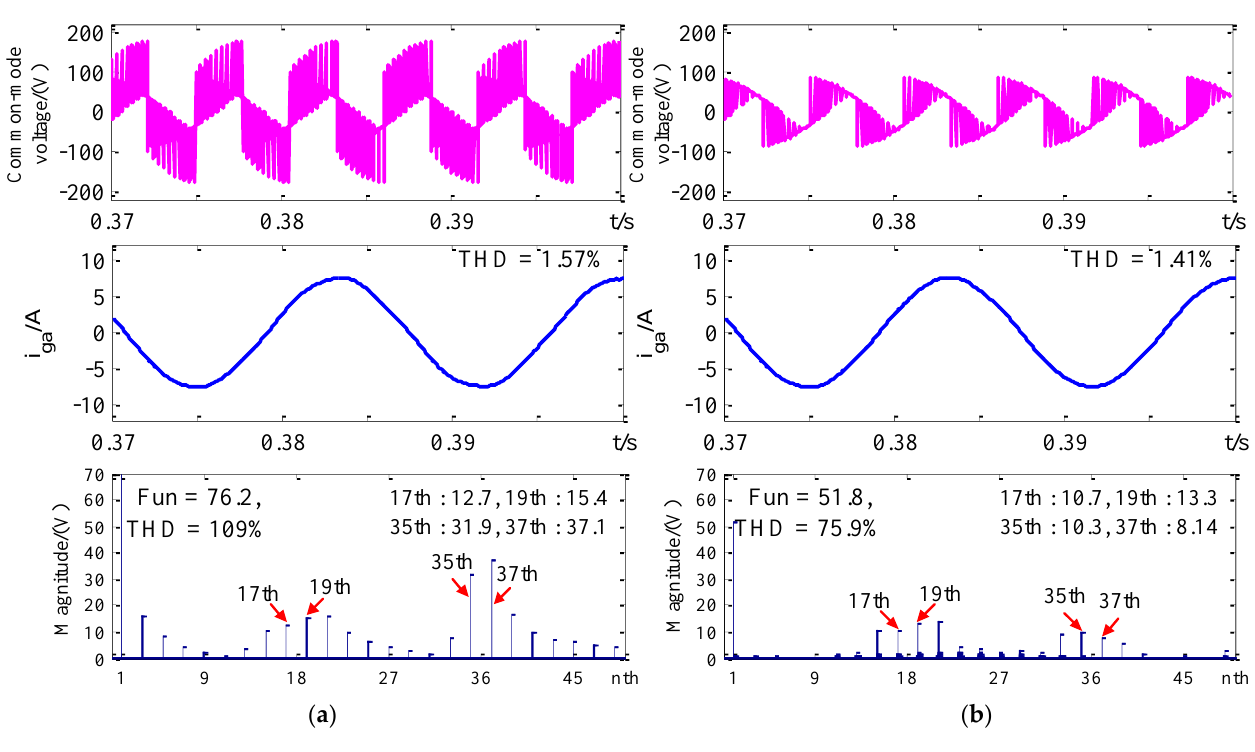
Figure 11. CMV and 𝑖 𝑔𝑎 ( 𝑚 𝑎 = 0.833 and 𝜙 = −30 ° ): ( a ) SVM1 and ( b ) SVM2. Figure 11. CMV and i ga ( m a = 0.833 and φ = − 30